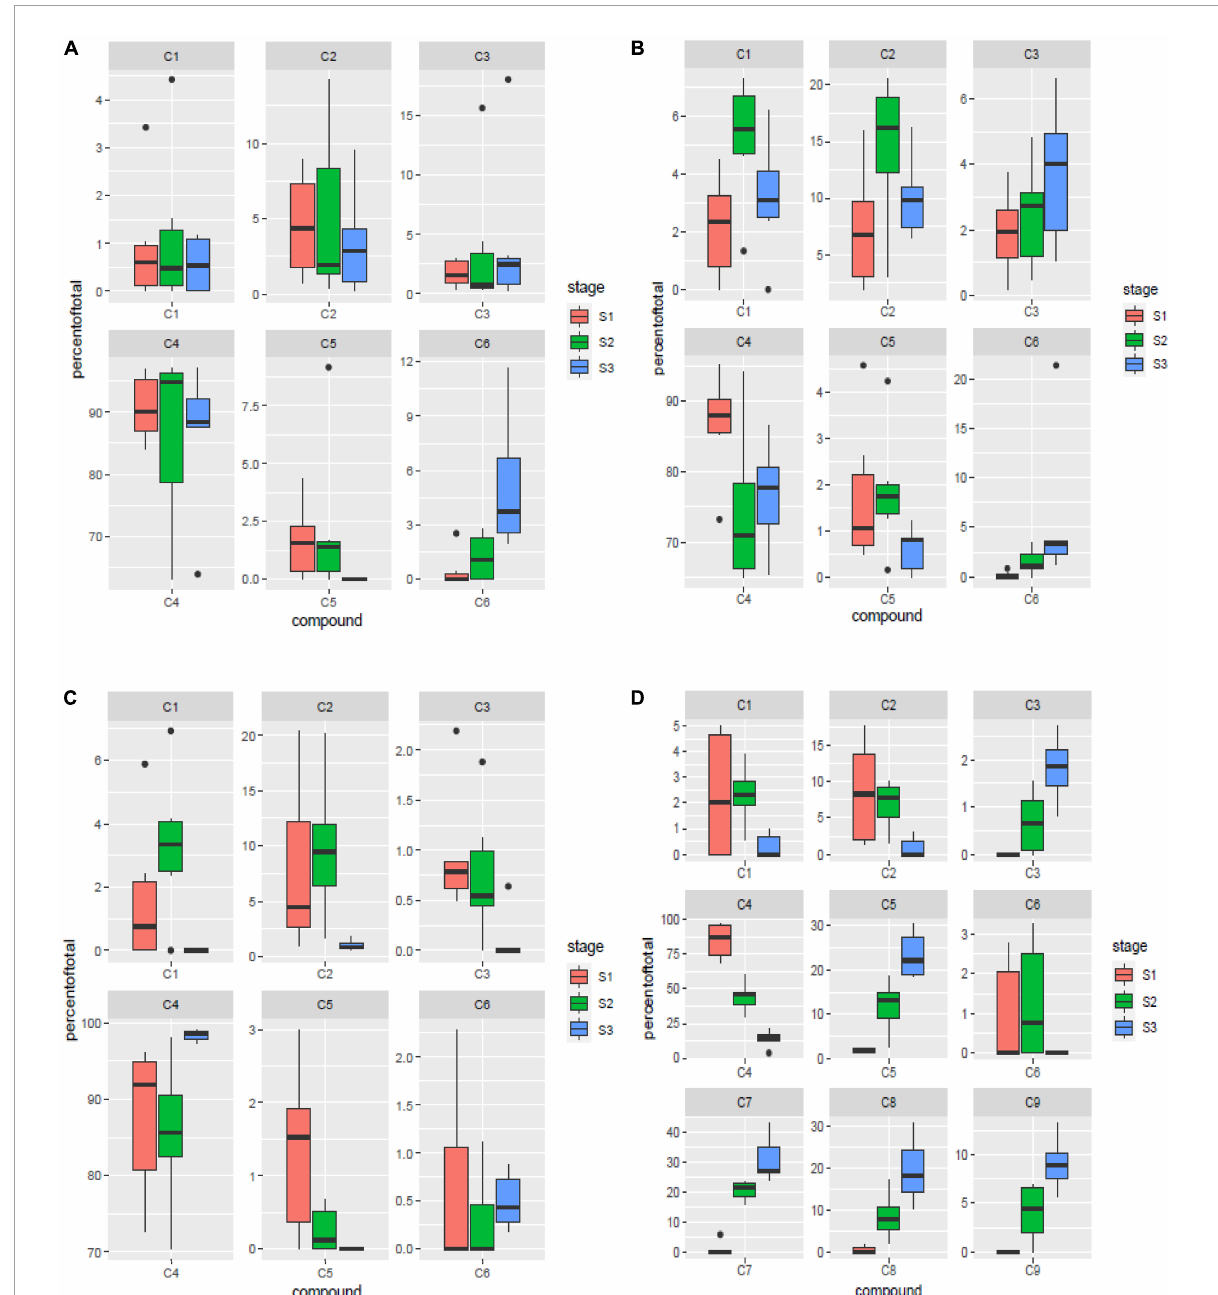
FIGURE3 Spatial variation for components of γ -oryzanol in leaf blades (A) , leaf sheaths (B) , peduncles (C) and spikelets (D) . S1: booting stage; S2: milky stage and S3: dough stage. C1: 24-methylenecycloartanyl- p -coumarate; C2: (cid:49) 7-stigmastenyl ferulate; C3: stigmasteryl ferulate; C4: cycloartenyl caffeate; C5: cycloartenyl ferulate; C6: campesteryl caffeate; C7: 24- methylenecycloartanyl ferulate; C8: campesteryl ferulate; C9: β -sitosteryl